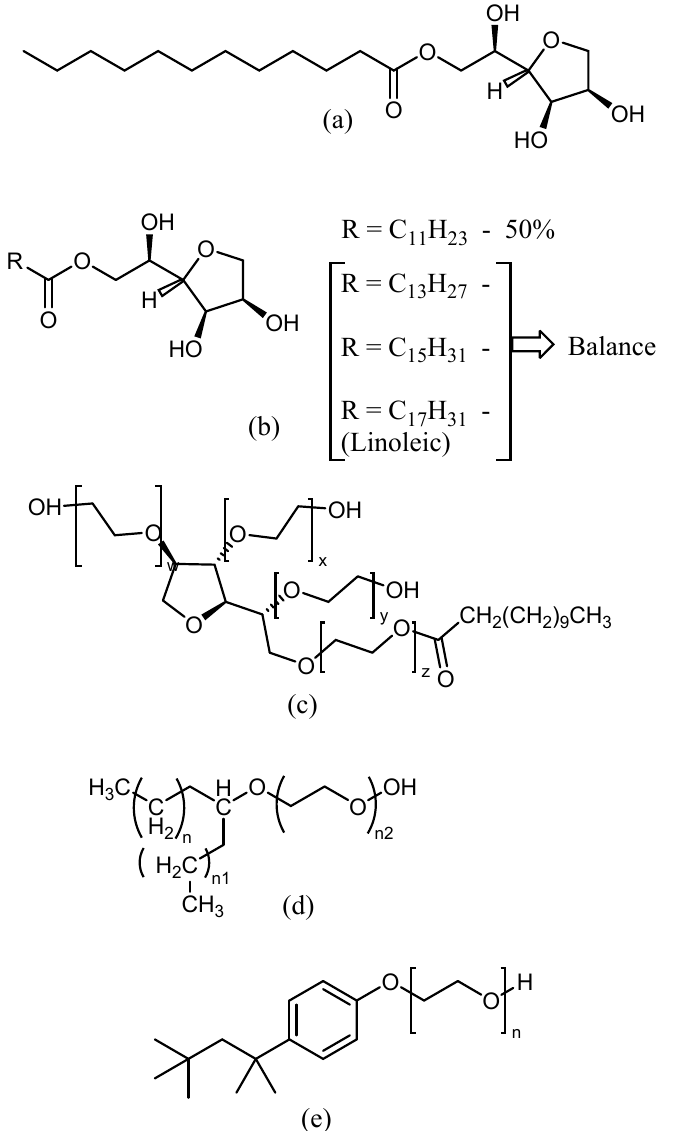
Figure 1. Structures of nonionic surfactants ( a ) sorbitan monolaurate Span-20, ( b ) other sorbitans, ( c ) polyethylene glycol sorbitan monolaurate, Tween 20, ( d ) Tergitol, and ( e ) Triton X-100.